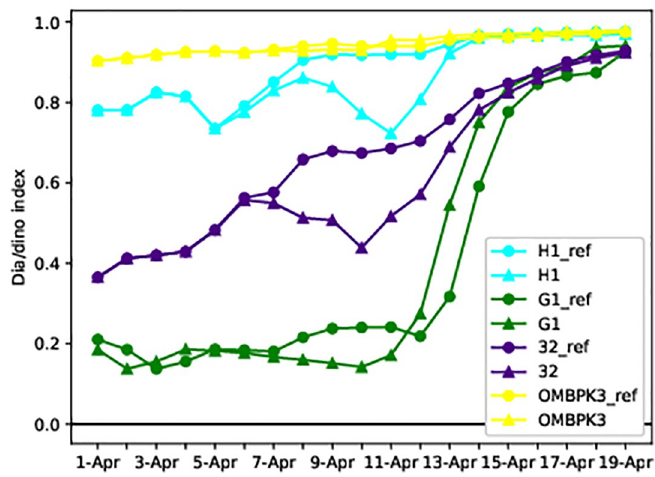
Fig 13. Increase of dinoflagellates due to the wind reduction. Dia/dino index in the reference run is represented by circles, and by triangles in the wind reduction scenario.